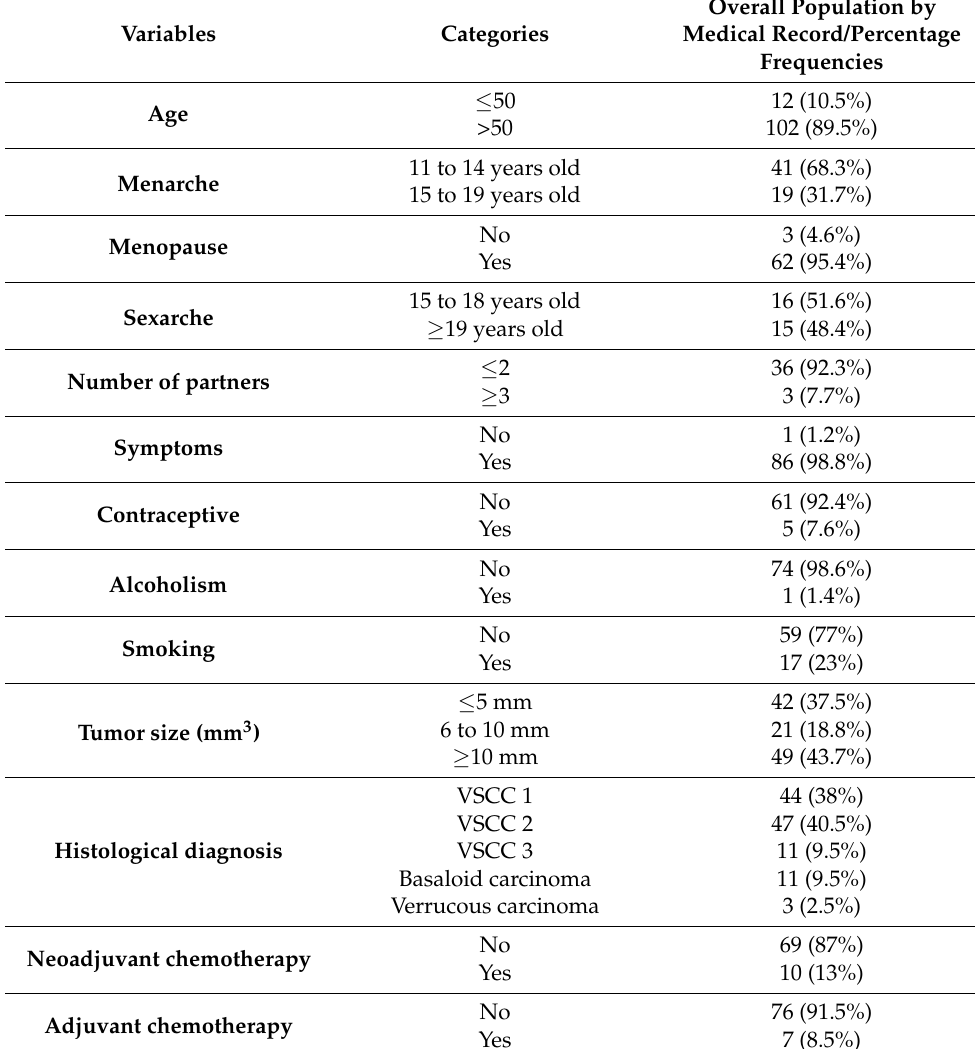
Table 1. Clinical and histopathological features of patients with VSCC ( n = 117).